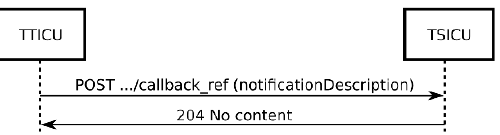
Figure 10. Flow of the notification procedure.